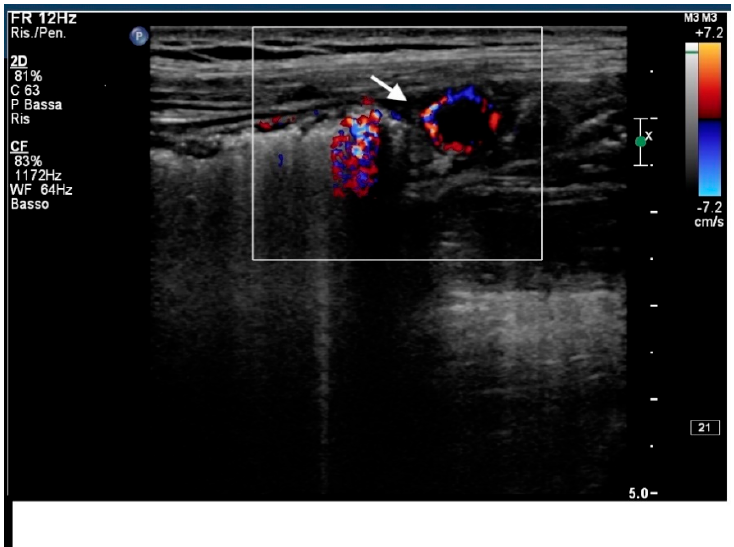
Figure 2. Transverse real-time ultrasound scan of the right lower quadrant performed with a high- frequency transducer (5–12 MHz), showing appendix involvement in EG with thickening of the wall, target sign, diameter >6 mm, hyperemia of the wall, and surrounding free fluid.